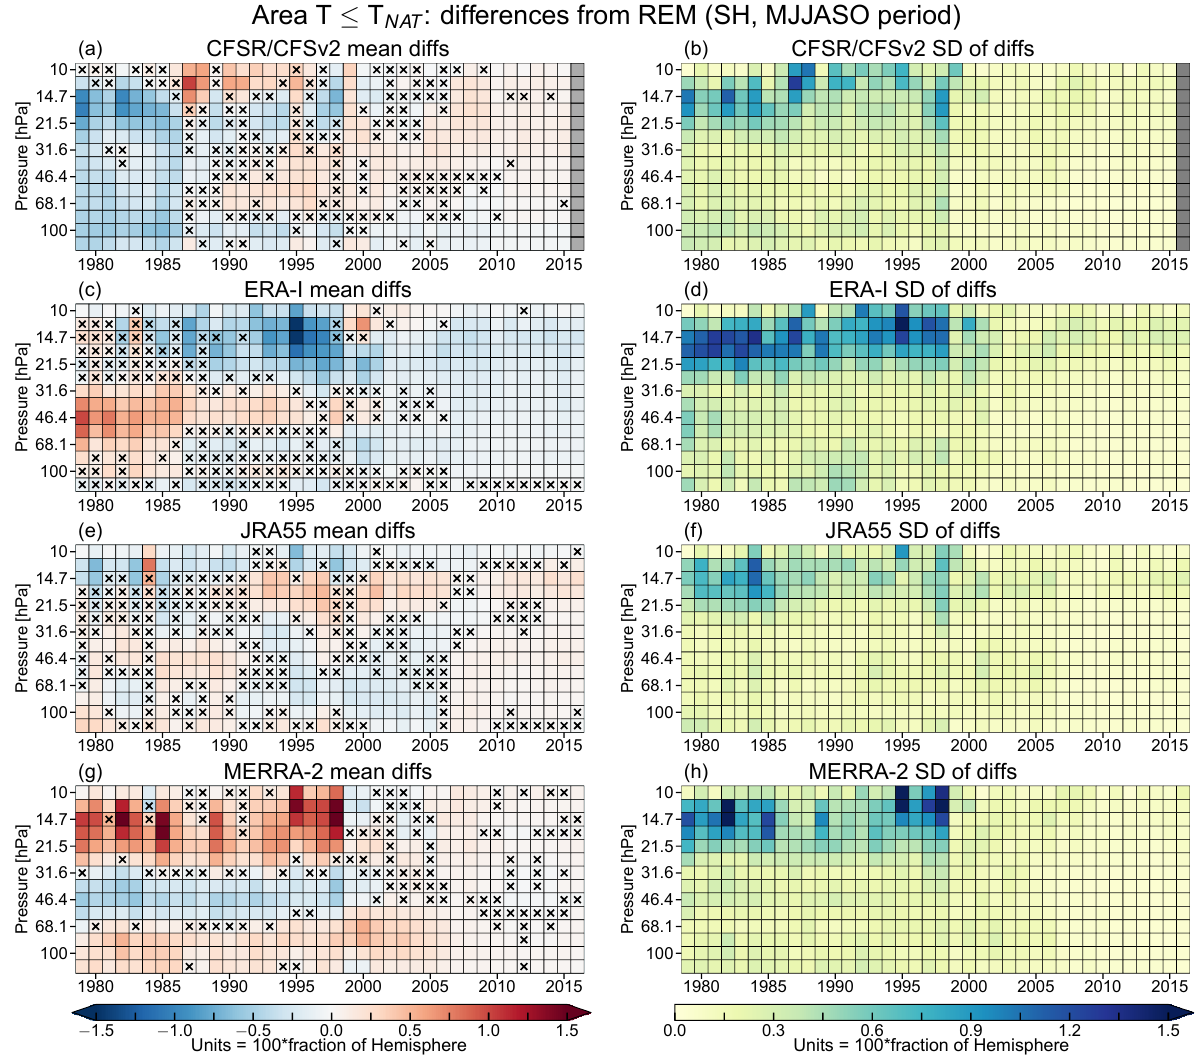
Figure 7. As in Fig. 4 but for area with temperatures below the NAT PSC threshold in the SH.